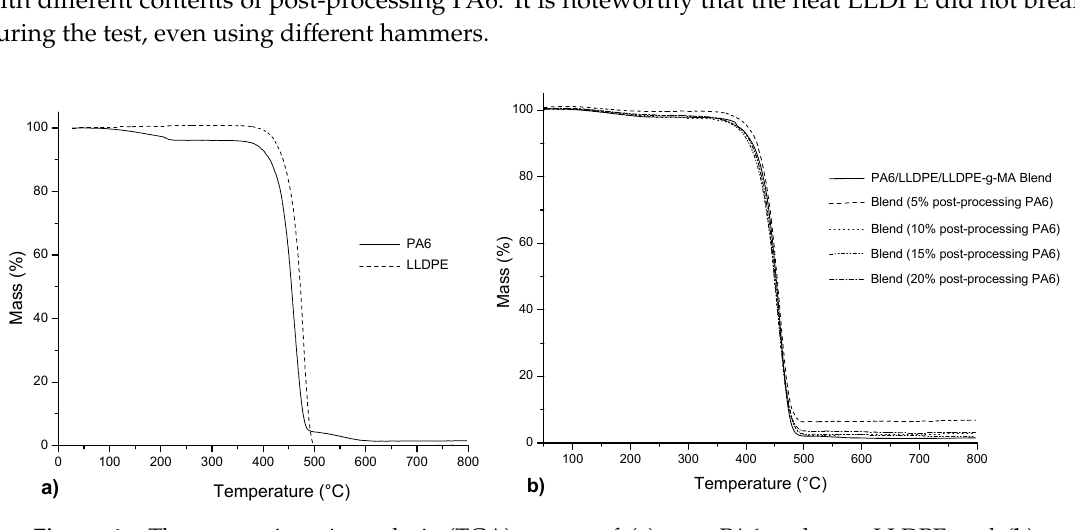
Figure 6. Thermogravimetric analysis (TGA) curves of ( a ) neat PA6 and neat LLDPE and ( b ) PA6/LLDPE/LLDPE- g -MA blends with different contents of post-processing PA6.